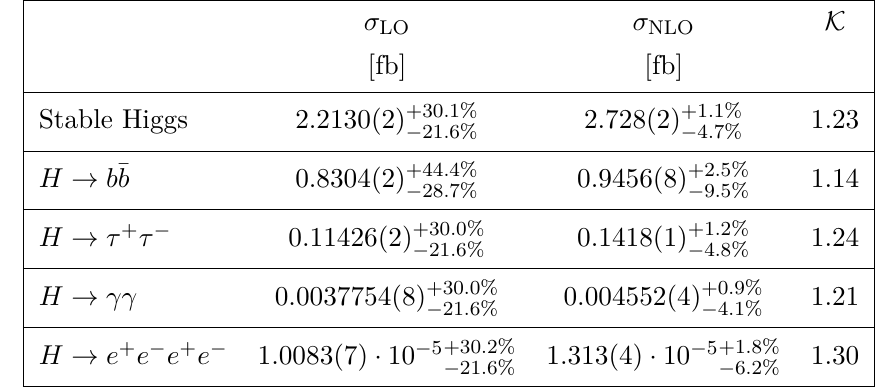
Table 6 . Integrated fiducial cross section at LO and NLO QCD for the pp → e + ν e µ − ¯ ν µ b ¯ b H process √ at the LHC with s = 13 TeV. Also listed are predictions with the following Higgs boson decays: b ¯ b , τ + τ − , γγ and e + e − e + e − . Results are given for µ 0 = H T / 2 and µ R, dec = m H . The default NNPDF3.1 PDF set is employed. The last column shows the K -factor defined as K = σ NLO /σ LO